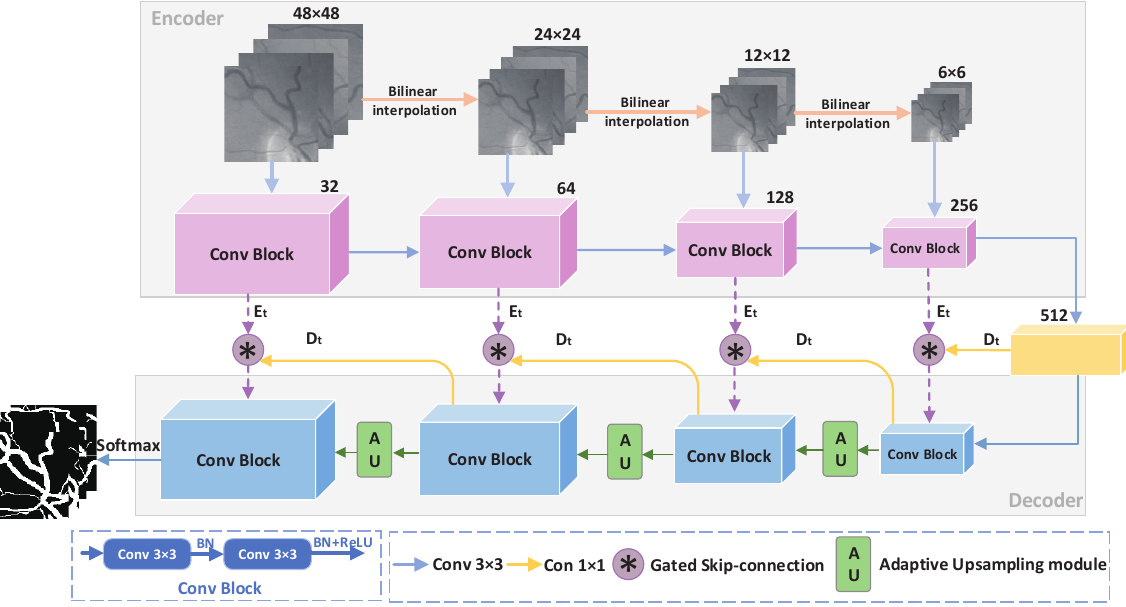
Figure 1. The GSAU-Net